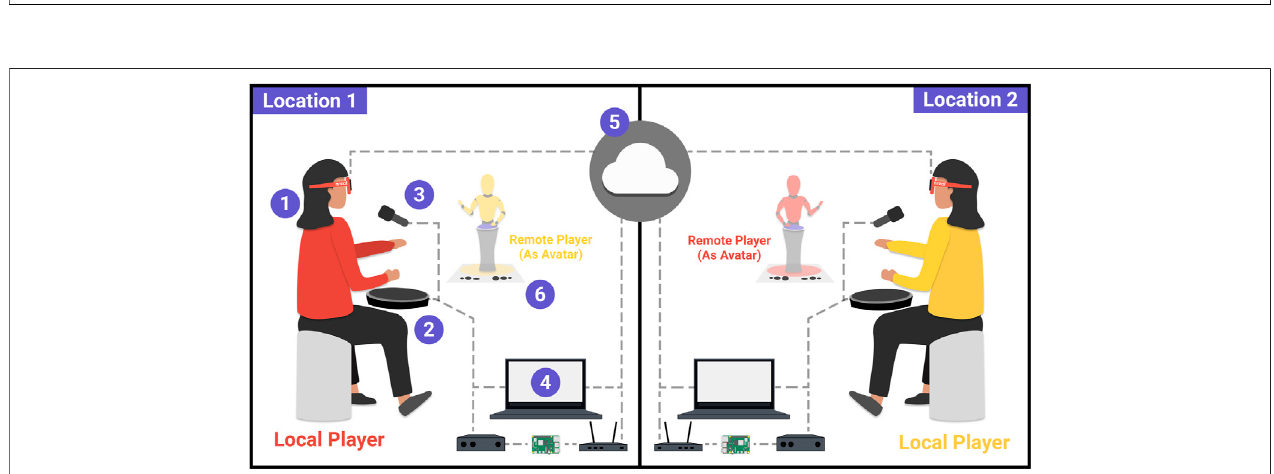
FIGURE 3 | AR Drum Circle system overview schematic. (1) AR Headset (Nreal Light), (2) MIDI Drum Pad or acoustic drum, (3) Microphone for speech communication, (4) MIDI forwarding device, (5) Local UDP server and JackTrip server in Denver, (6) Room Environment ( via plane detection). MIDI notes from User 1 are routed to User 2 to trigger animation of the avatar in the fi eld of view of User 2 using the Local UDP server. Live audio is sent to nearby JackTrip servers to create near- instantaneous audio transmission.